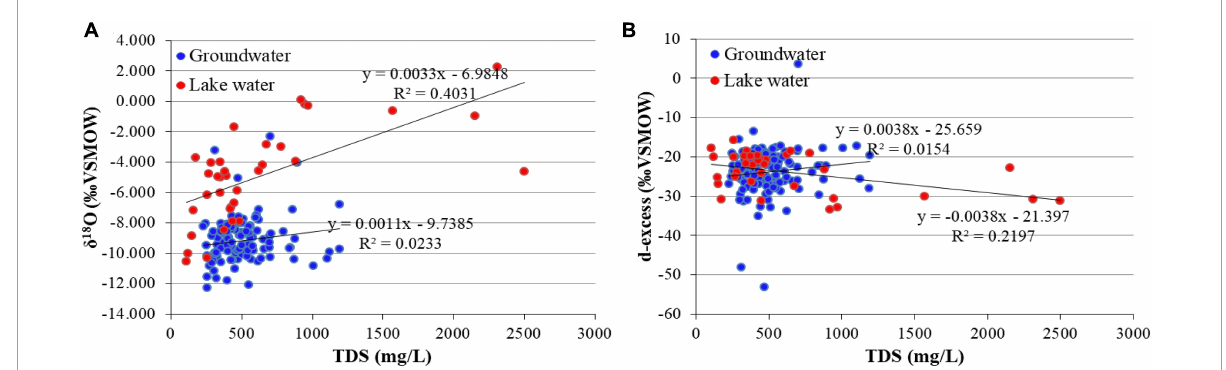
FIGURE7 Relationships between TDS and H and O stable isotope parameters. (A) TDS and δ 18 O; (B) TDS and